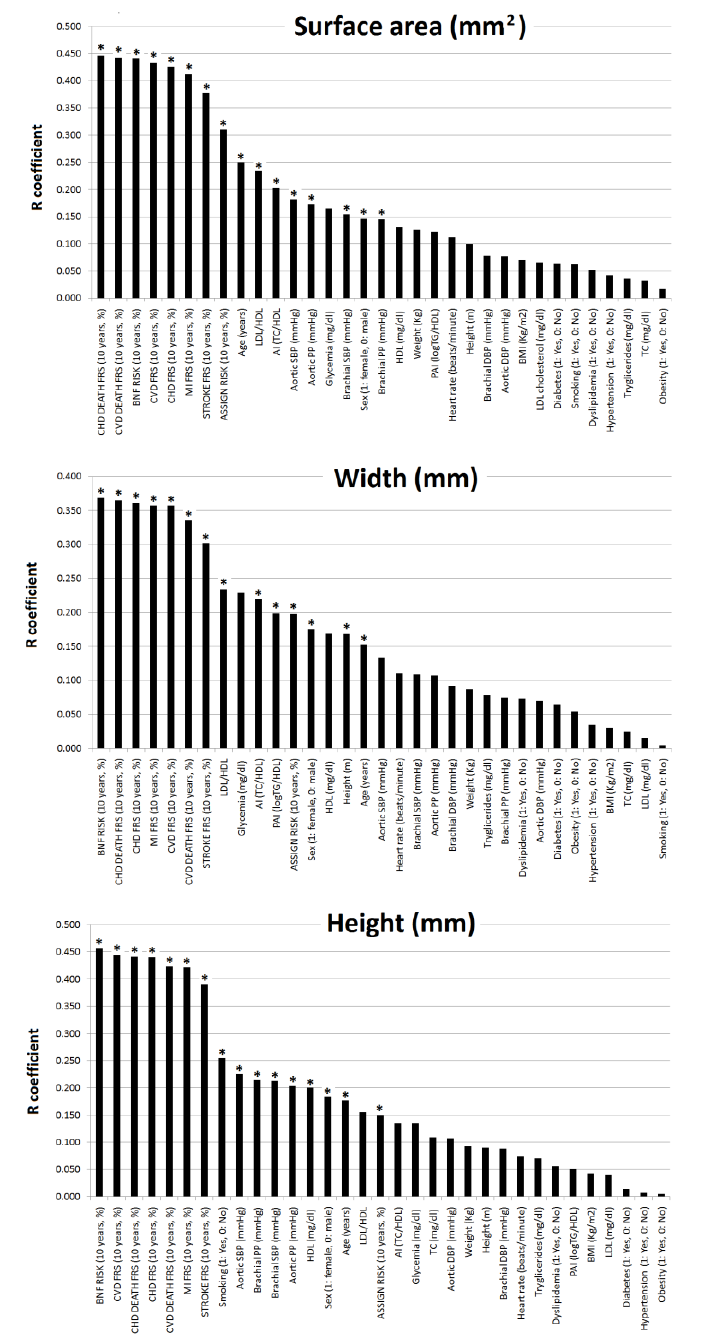
Figure 3. Strength of association (correlation coefficient absolute value, R) between subjects´ characteristics and plaque geometry ( n = 206). * p < 0.05.